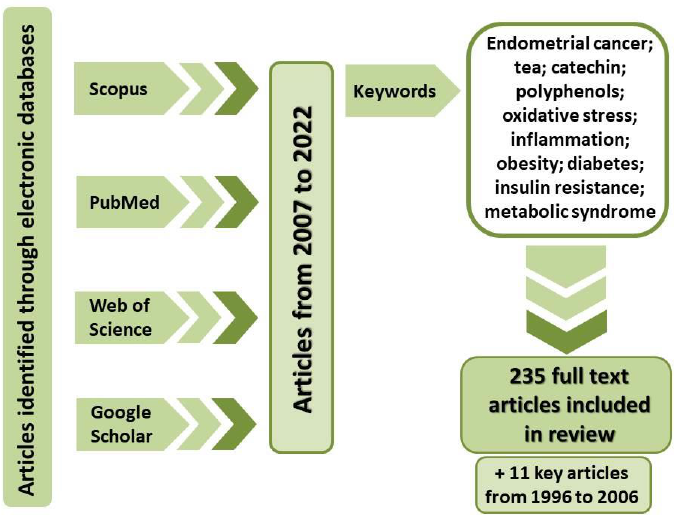
Figure 2. Literature search strategy.